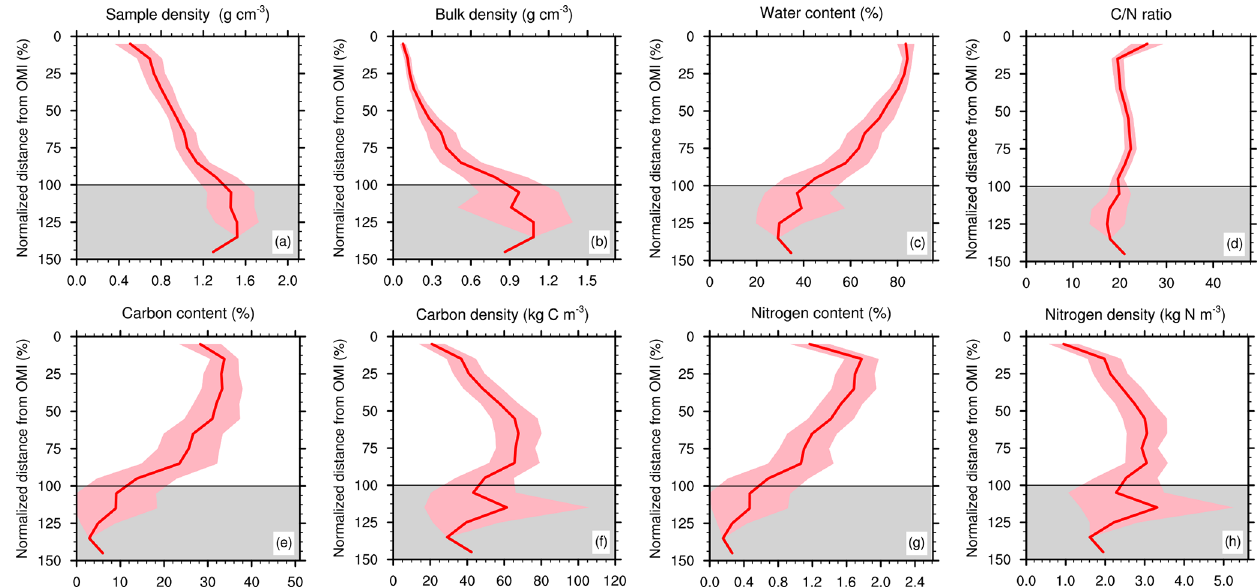
Figure 8. Same as Fig. 7, except profile depths are re-normalized from the organic–mineral interface. The grey area represents the zone below the OMI.